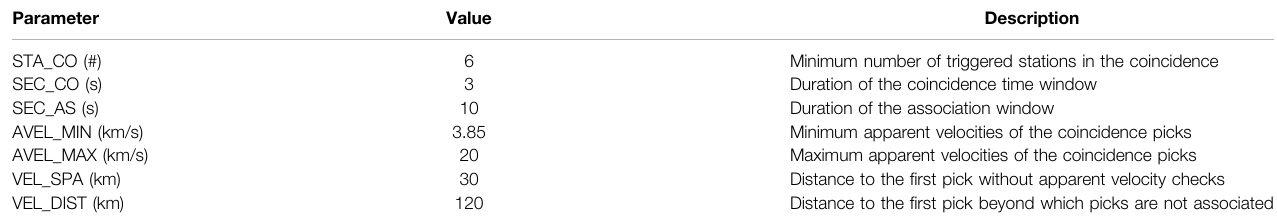
TABLE 2 | Con fi guration Parameters of the EDS binder. Parameter